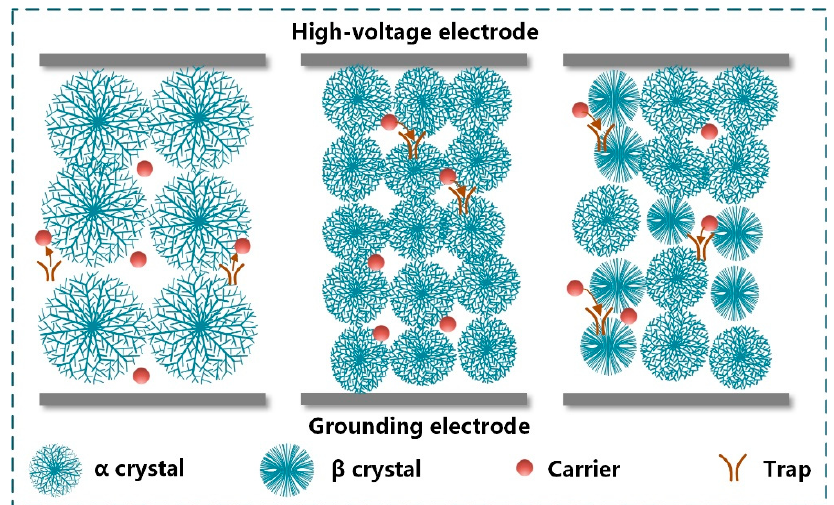
Figure 14. The mechanism of the effect of crystallization on carrier transport.